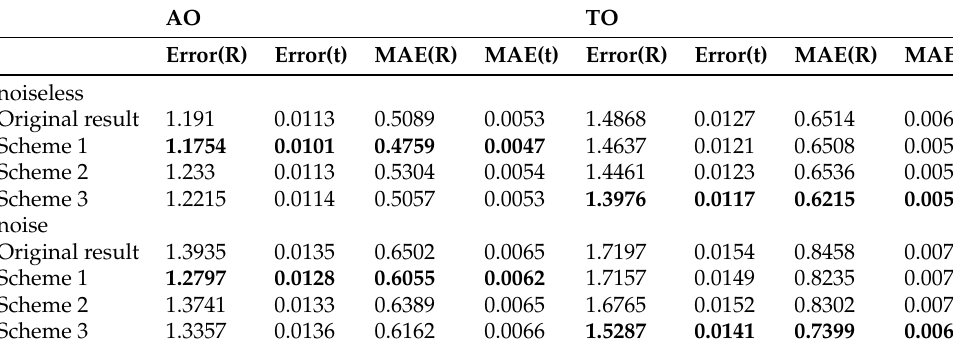
Table 3. Results of metrics with different